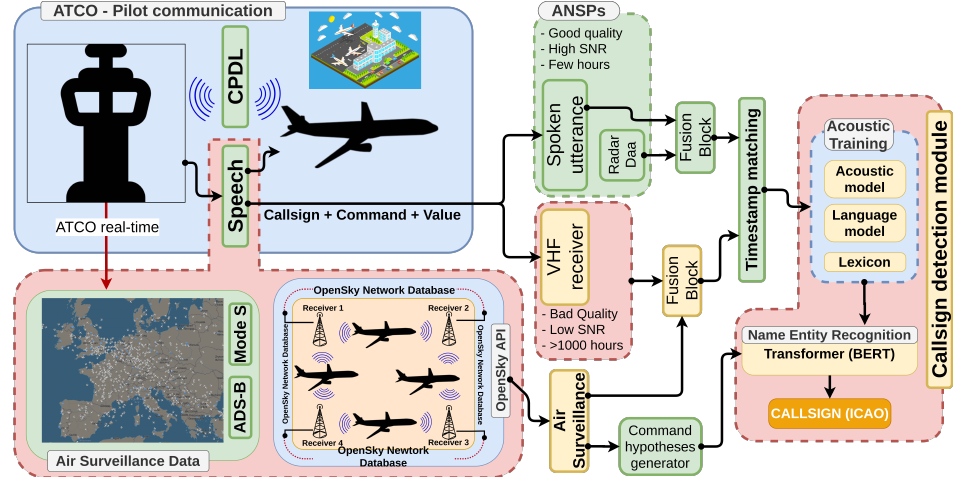
Figure 1. ATCO 2 proposed workflow for matching air surveillance data and spoken